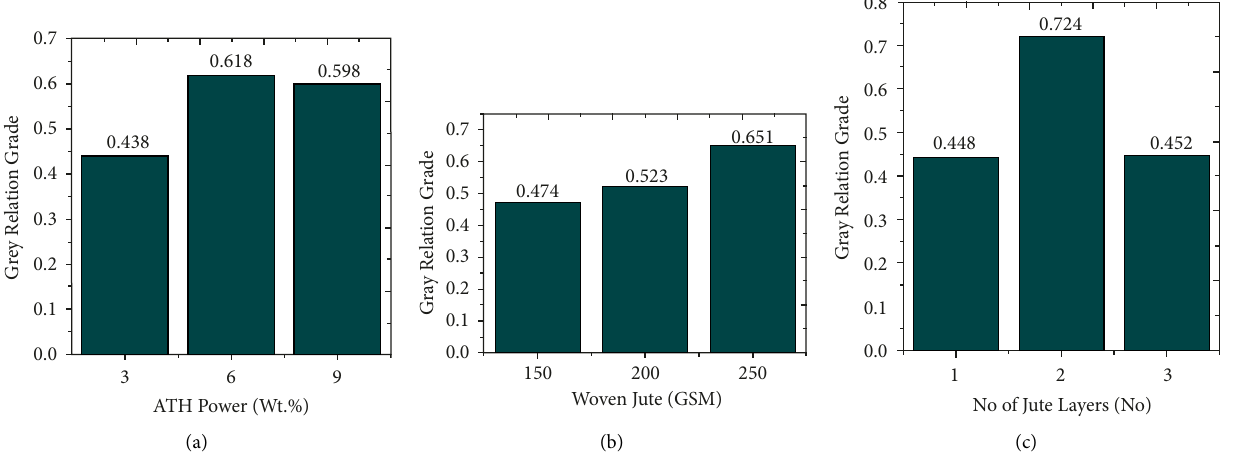
Figure 1: . (a) Grey relational grade outcomes of (a) ATH powder wt.%. (b) Grey relational grade outcomes of (b) woven jute type GSM. (c) Grey relational grade outcomes of (c) amount of jute layers